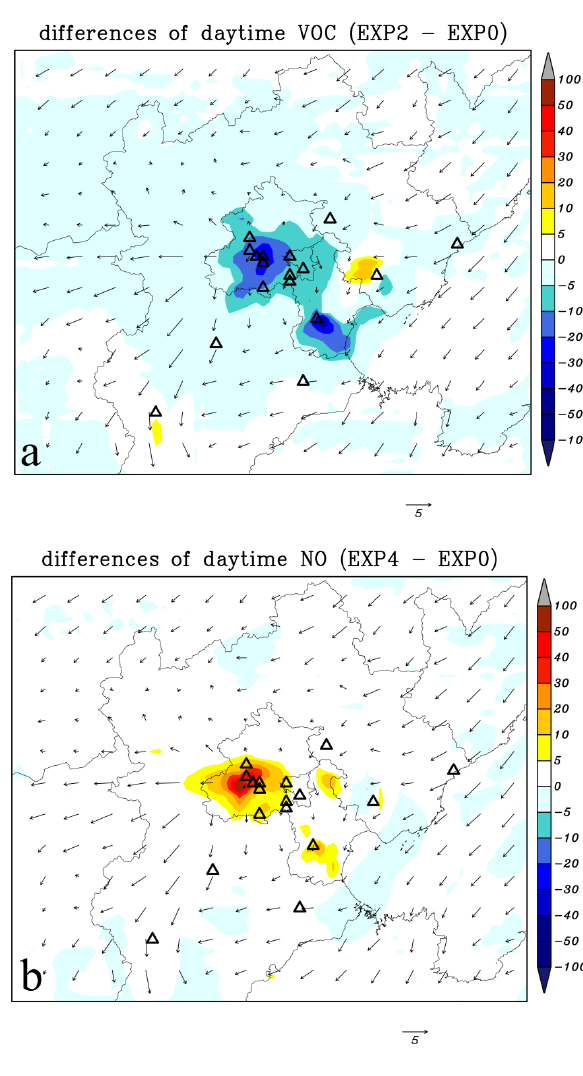
Fig. 6. (a) Departure of daytime VOCs concentrations (ppbv) in EXP2 from those in free run during 10am-4pm on 14 August 2008 (LT); (b) Departure of daytime NO concentrations (ppbv) in EXP4 from those in free run during 10am-4pm on 14 August 2008 (LT).